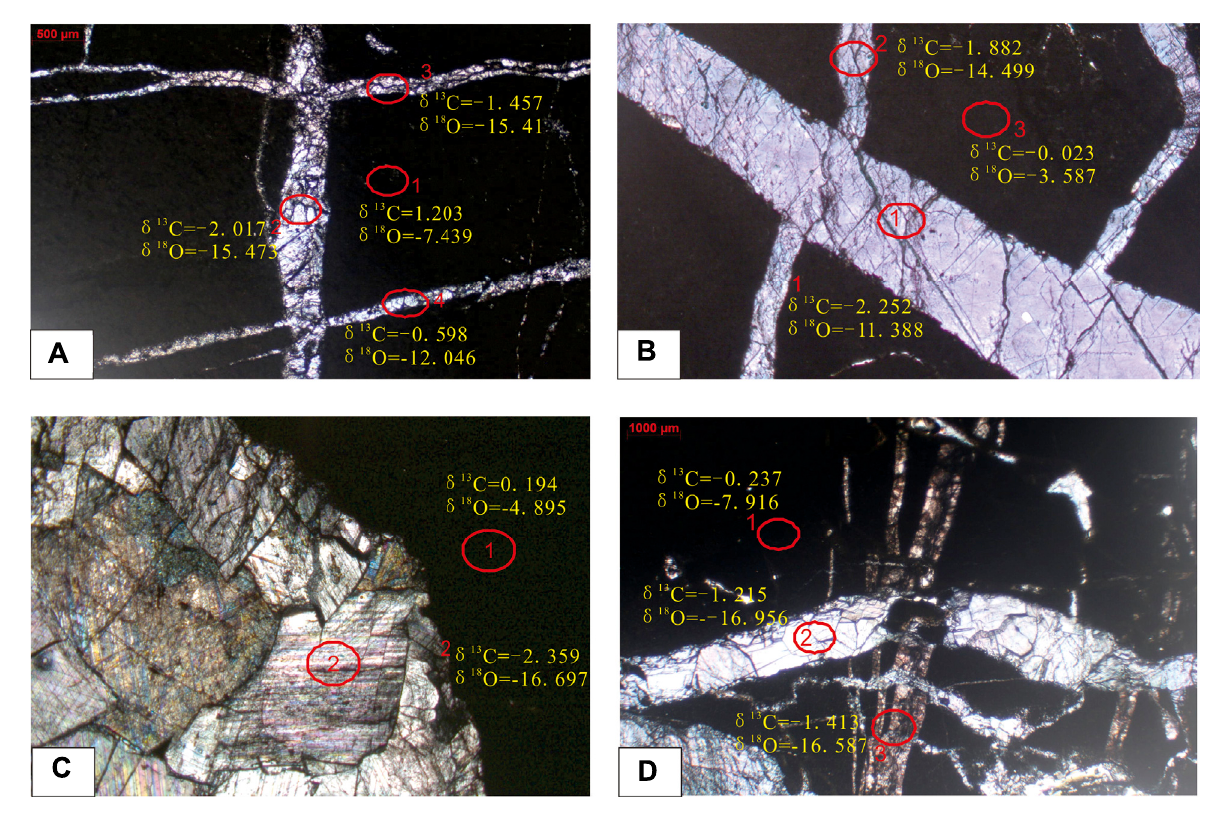
Fillings in structural fractures in buried hill and their C and O isotopes. [ (A) : 3563.18 m; (B) 3563.43 m; (C) 3565.15 m; (D) 3565.53 m, as shown in Table